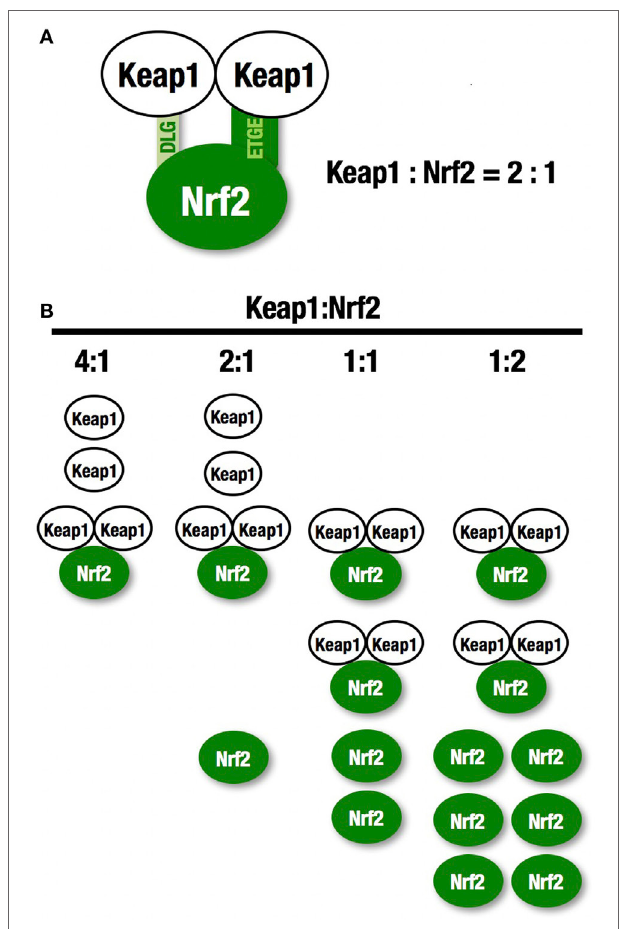
FigURe 1 | KeAP1 and NRF2 . (A) Two KEAP1 molecules and one NRF2 form a trimer through the DC domain in KEAP1 and the DLG and ETGE motifs within the N-terminal Neh2 domain of NRF2. This two-site binding of NRF2 and KEAP1 has been shown to be the molecular basis of electrophile- induced NRF2 accumulation. (B) The ratio of KEAP1:NRF2 binding. KEAP1 is unable to bind a large amount of